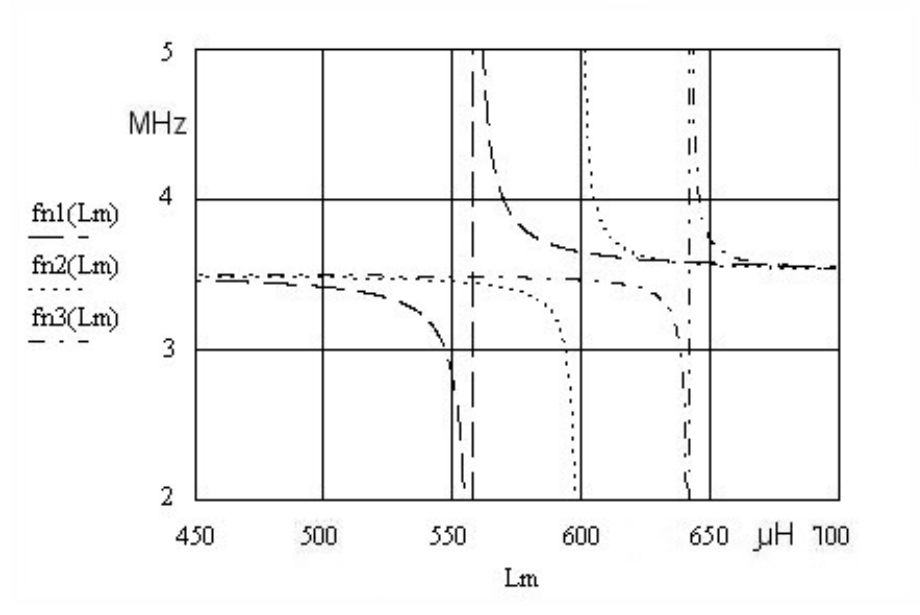
) for k = 1, fn2 ( L m . m